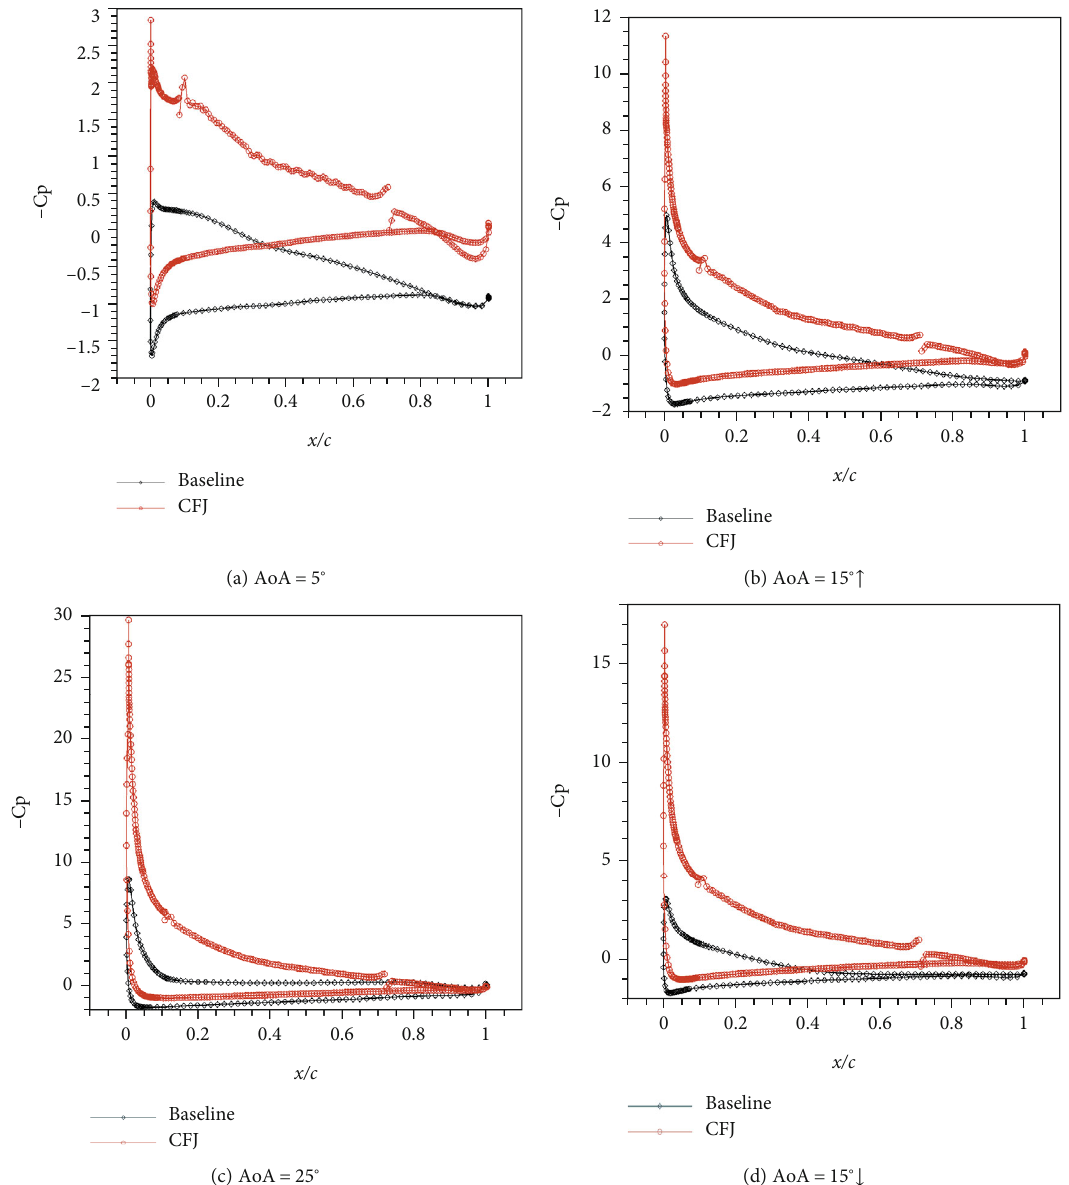
Figure 10: Comparison between the pressure coe ffi cients of the OA212 baseline and CFJ airfoils at di ff erent